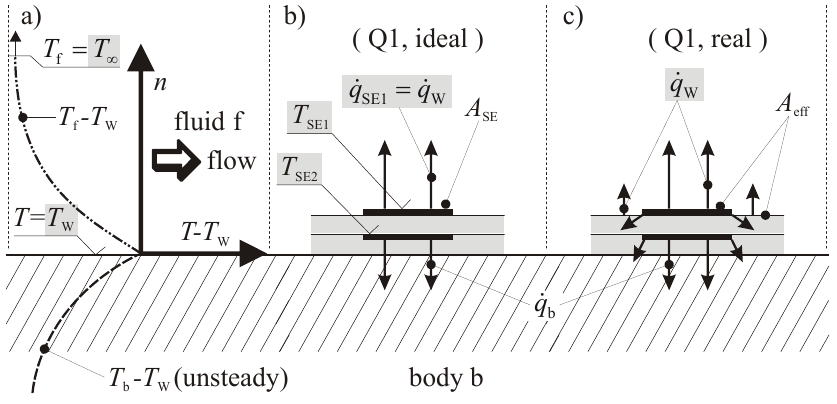
Figure 11. Heat transfer situation of a double foil sensor in active